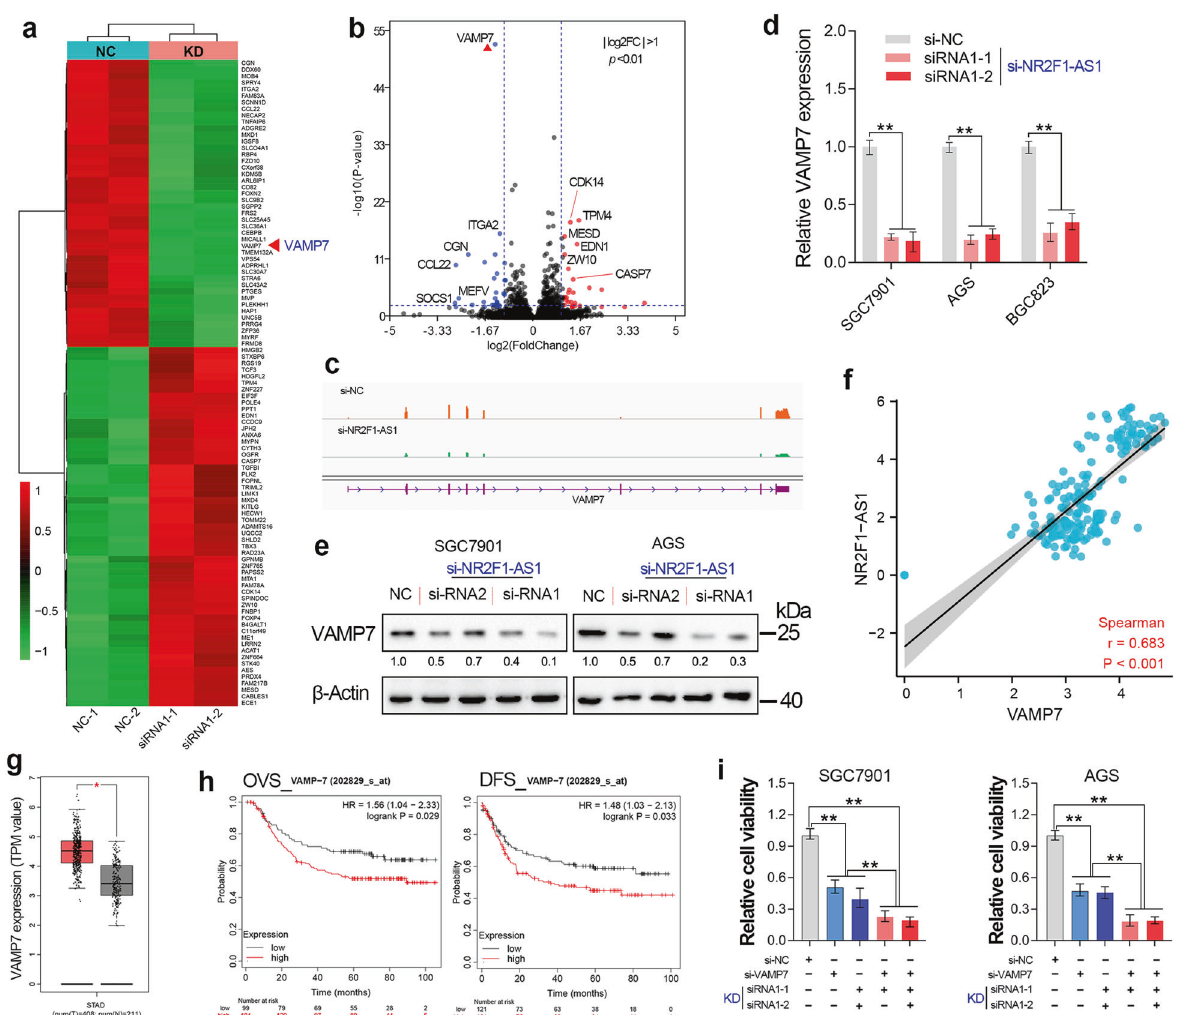
Fig. 6 NR2F1-AS1 promotes GC progression through maintaining VAMP7 overexpression. a The heat map reveals the top 100 differentially expressed genes after NR2F1-AS1 knockdown. b The differentially expressed genes (|Log2FC| > 1, P < 0.05) after NR2F1-AS1 depletion were shown in the volcano plot. c The transcripts abundance of VAMP7 after NR2F1-AS1 knockdown. d , e The mRNA level and protein level of VAMP7 were determined after knockdown of NR2F1-AS1. f High co-expression between NR2F1-AS1 and VAMP7 was observed in stomach tissues. g GEPIA analysis revealed that VAMP7 was upregulated in stomach cancer tissues. h Survival analysis indicated that GC patients with relatively high expression of VAMP7 had shorter overall and disease-free survival time. i Rescue assay con fi rmed that NR2F1-AS1 knockdown inhibited GC progression through regulating VAMP7 expression. ** P <